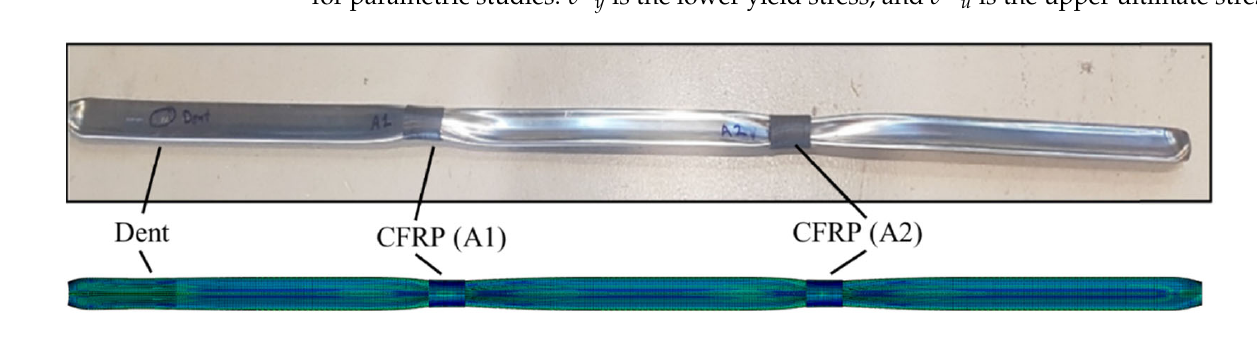
Figure 9. Comparison of experimental results [44] and numerical simulations. Table 3. Comparison between the numerical simulation and experiments in the literature [44].